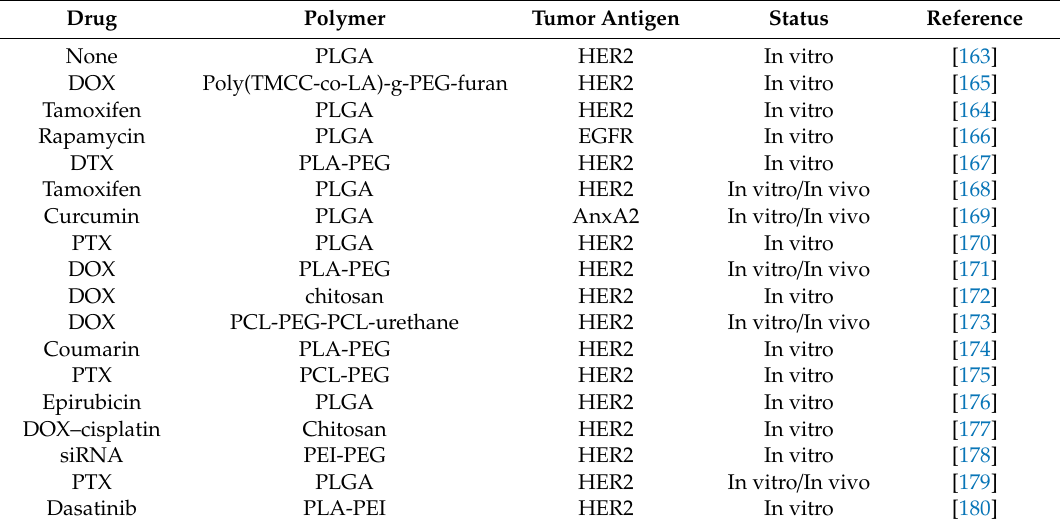
Table 3. Polymeric ACNPs for breast cancer therapy. PEI: polyethylenImine,